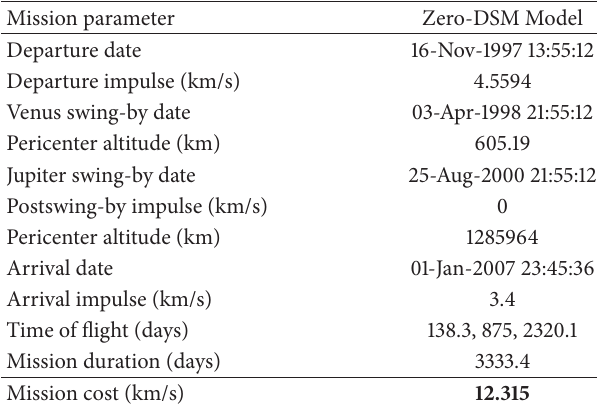
Table 10: Zero-DSM model trajectory of Cassini 2 mission using